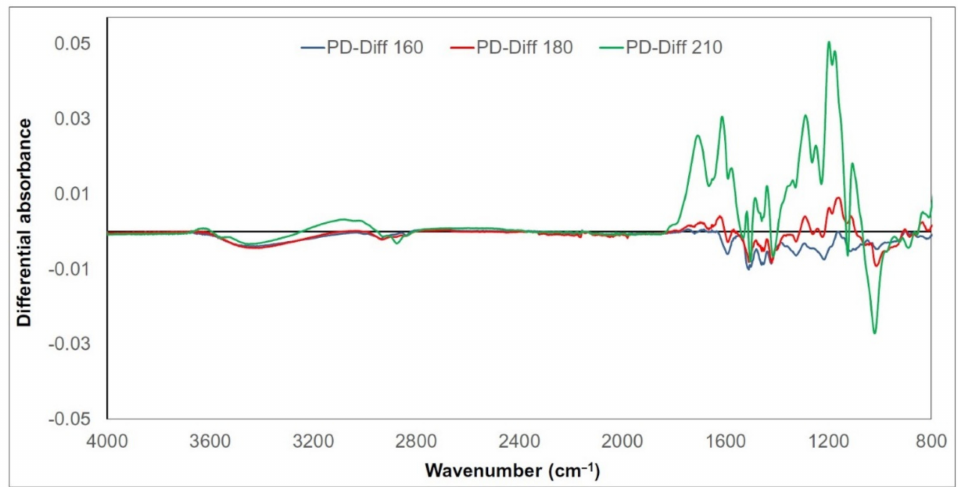
Figure 5. Differential FTIR spectra of thermally treated padauk wood lignin.